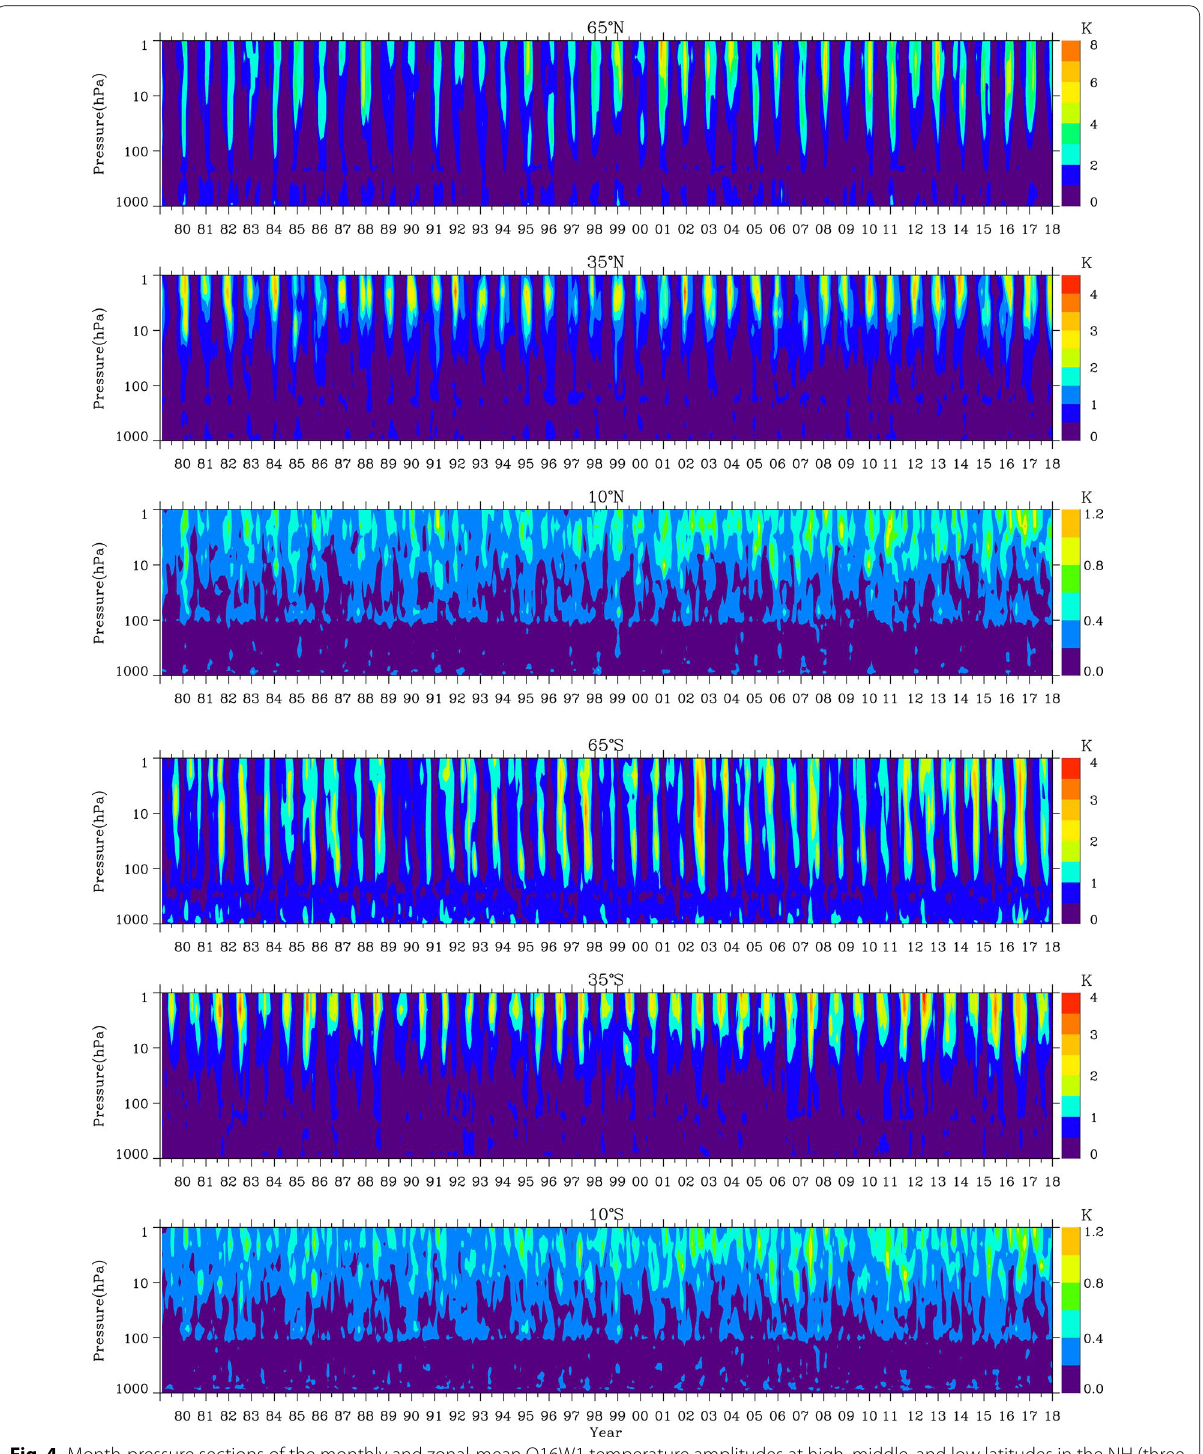
Fig. 4 Month-pressure sections of the monthly and zonal-mean Q16W1 temperature amplitudes at high, middle, and low latitudes in the NH (three upper rows) and SH (three lower